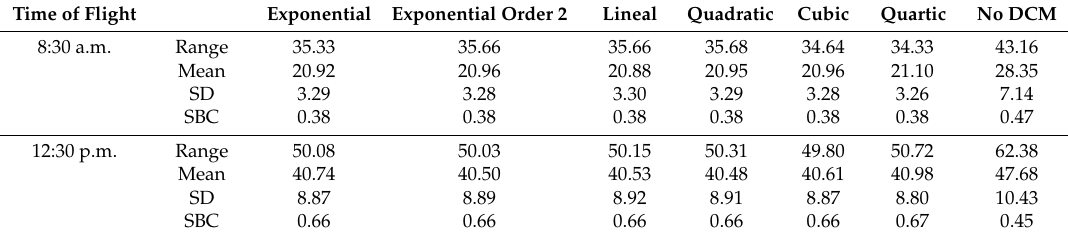
Figure 5. Thermal orthomosaic histograms at ( a ) 8:30 a.m., ( b ) 12:30 p.m., ( c ) 16:30 p.m., and ( d ) 18:30 p.m. for each drift correction model and without correction. Table 3. Statistics of thermal